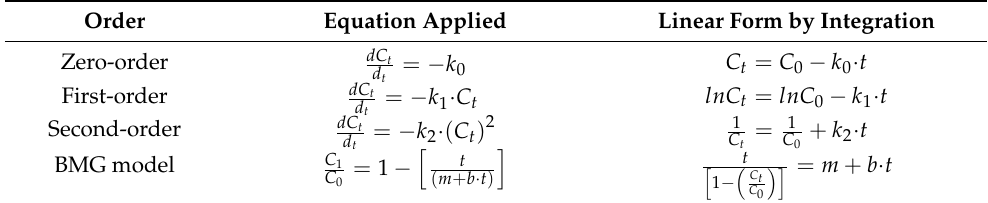
Table 1. The equations of kinetic equations. Order Equation Applied Linear Form by Integration